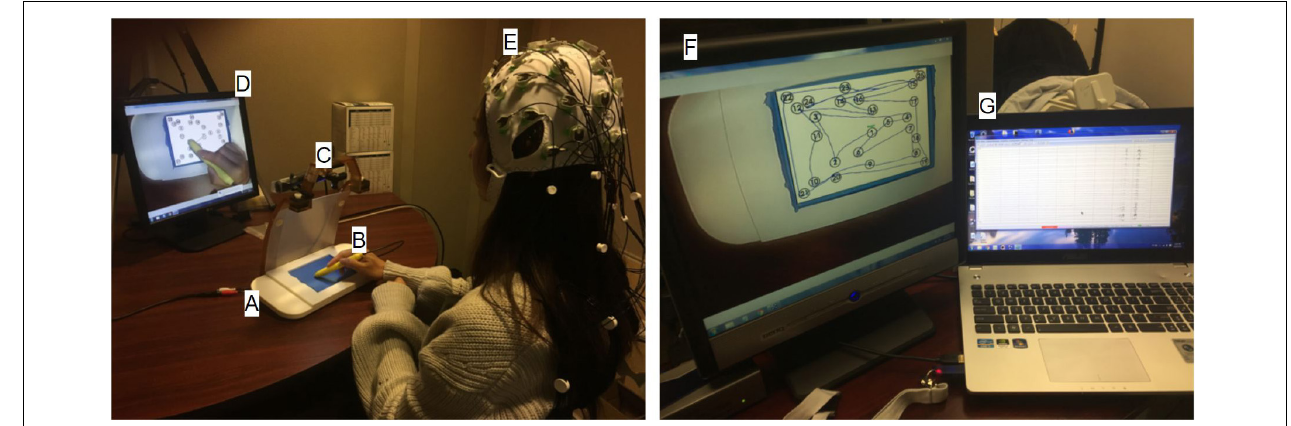
FIGURE 2 | The experimental setup inside (left) and outside (right) the acoustically shielded room. (A) Touch-sensitive tablet, (B) Stylus, (C) Video camera, (D) Visual feedback of stimulus response and hand position, (E) EEG cap and electrodes, (F) Stimulus/response computer, (G) EEG recording computer.